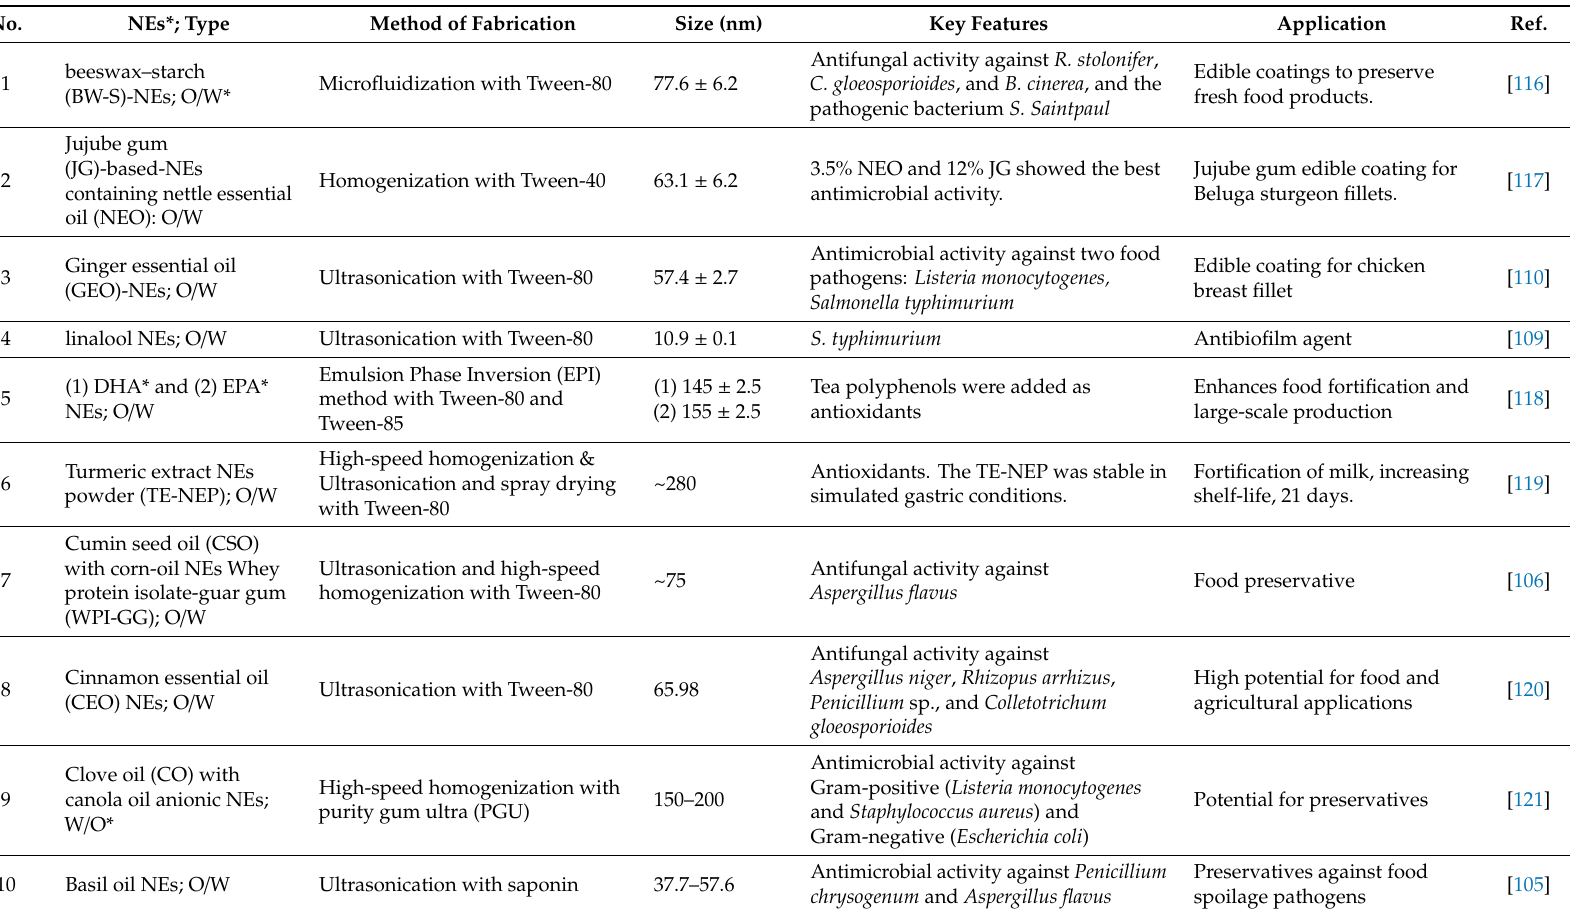
Table 6. Recent applications of NEs in food